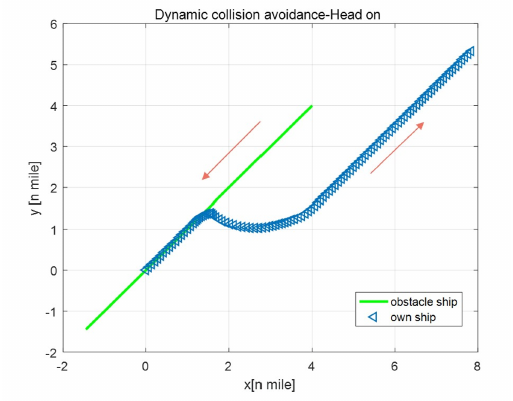
Figure 15. Trajectory of dynamic collision avoidance